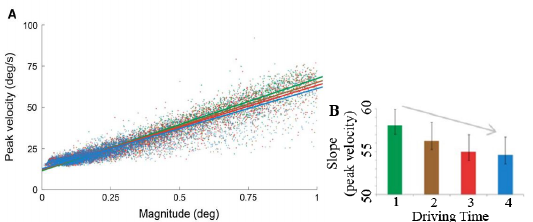
function of four binned driving times (1: green, 2: brown, 3: red, 4: blue; 30 min durations per bin). B) Average microsaccadic peak velocity for all participants for each 30 minutes of driving time (shown in the same bin colors as A). The significant linear trend of microsaccadic velocity over time is indicated by the arrow. Error bars indicate SEM across participants (n=7). Modified from Di Stasi et al.